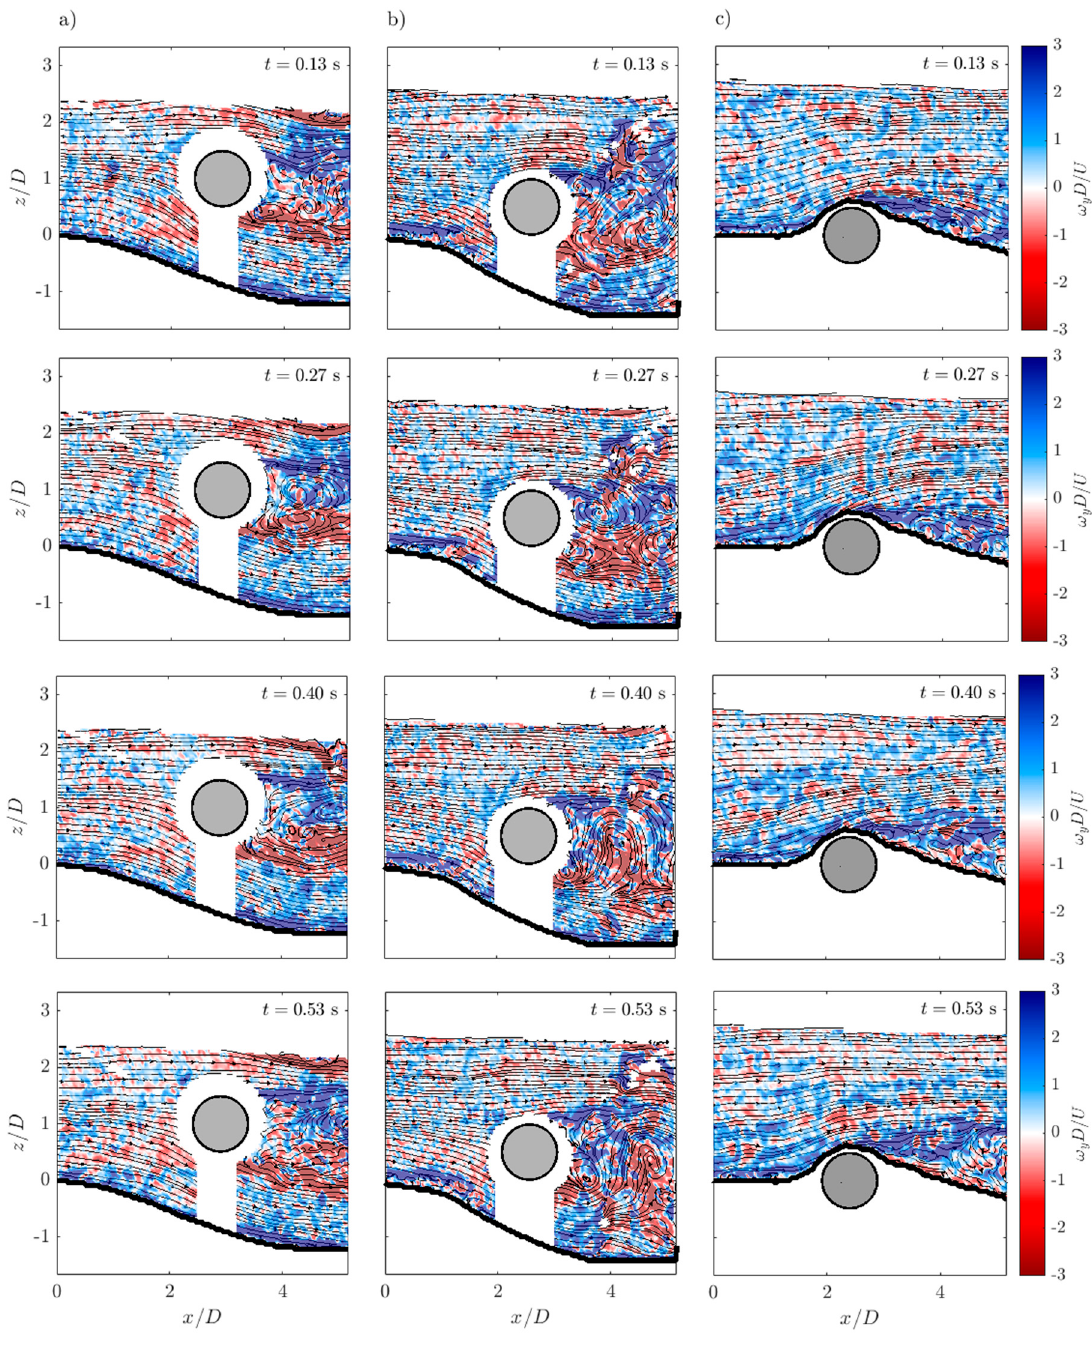
Figure 7. Dimensionless instantaneous vorticity fields at different times t on a vertical plane in ( a ) Run 1, ( b ) Run 2 and ( c ) Run 3.